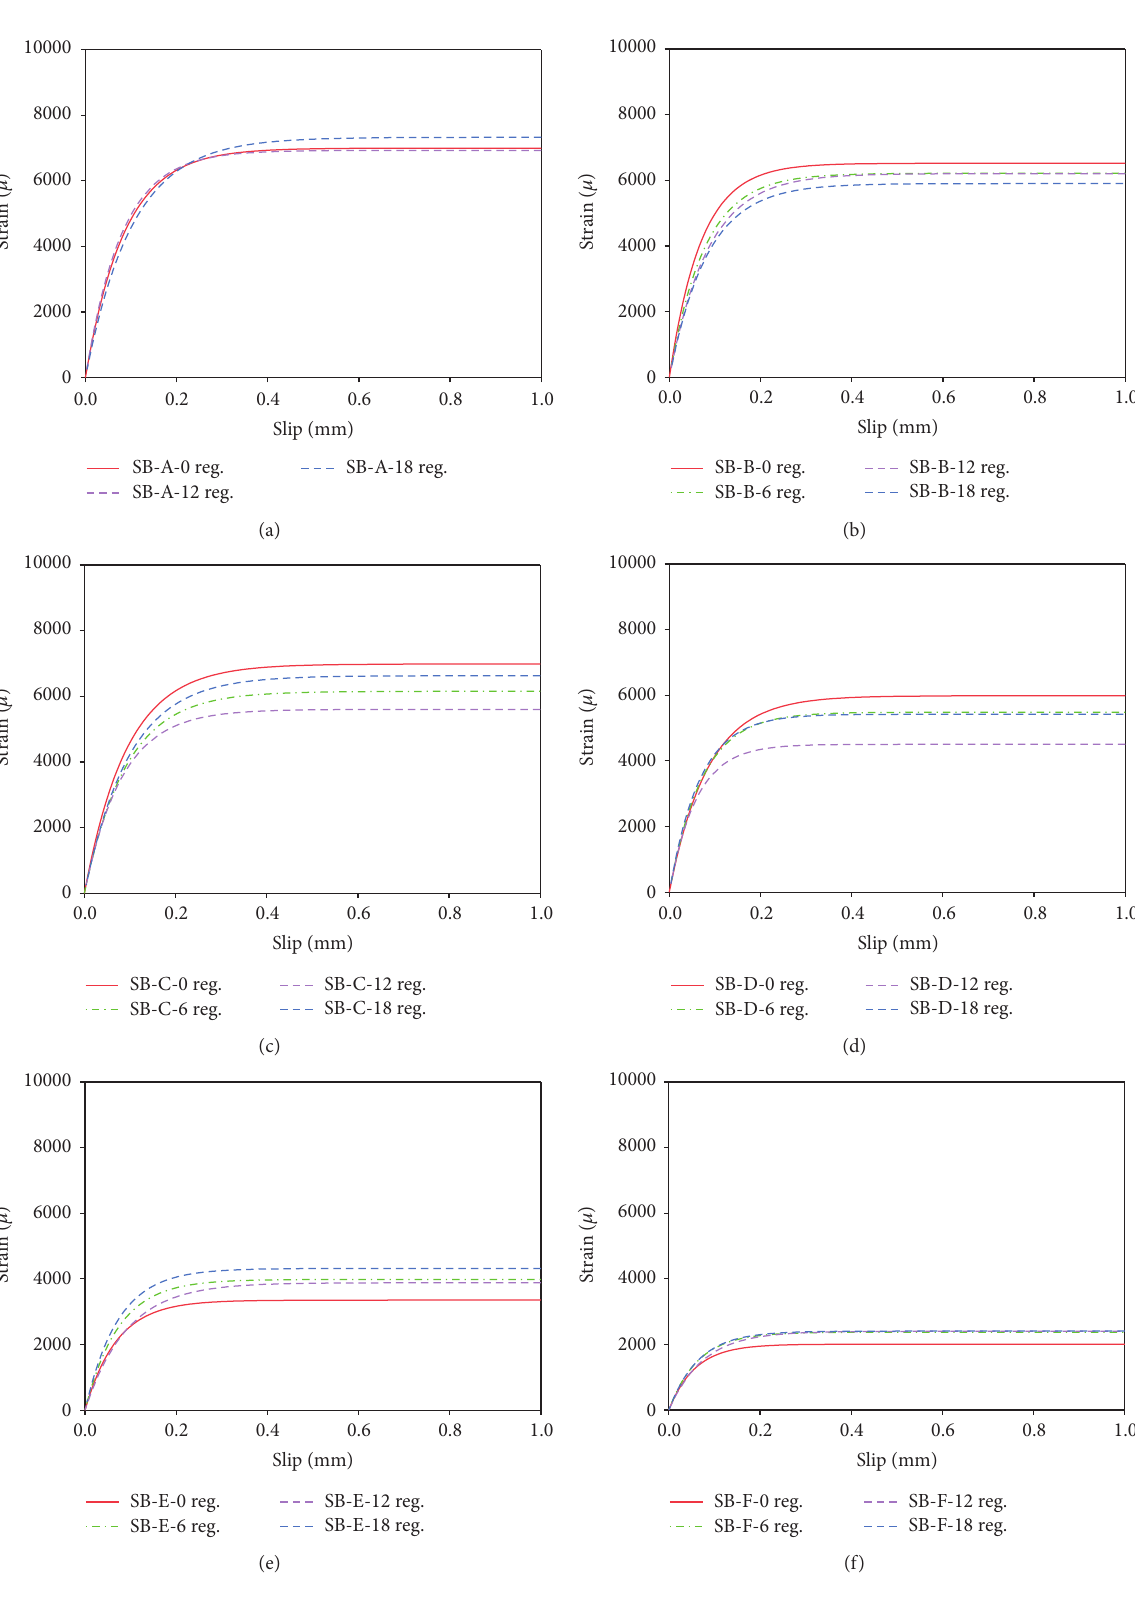
Figure 7: Regressed 𝜀 - 𝑠 curves for all the